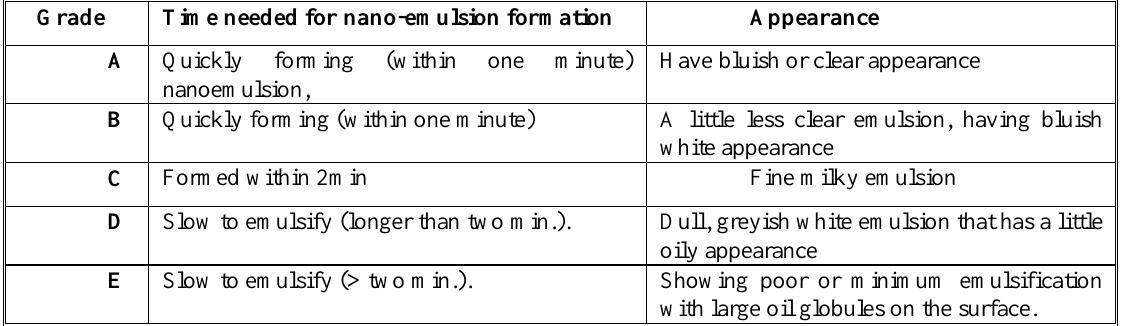
Table 2. Grading system of in vitro performance of the SNEDDS (Dispersibility and